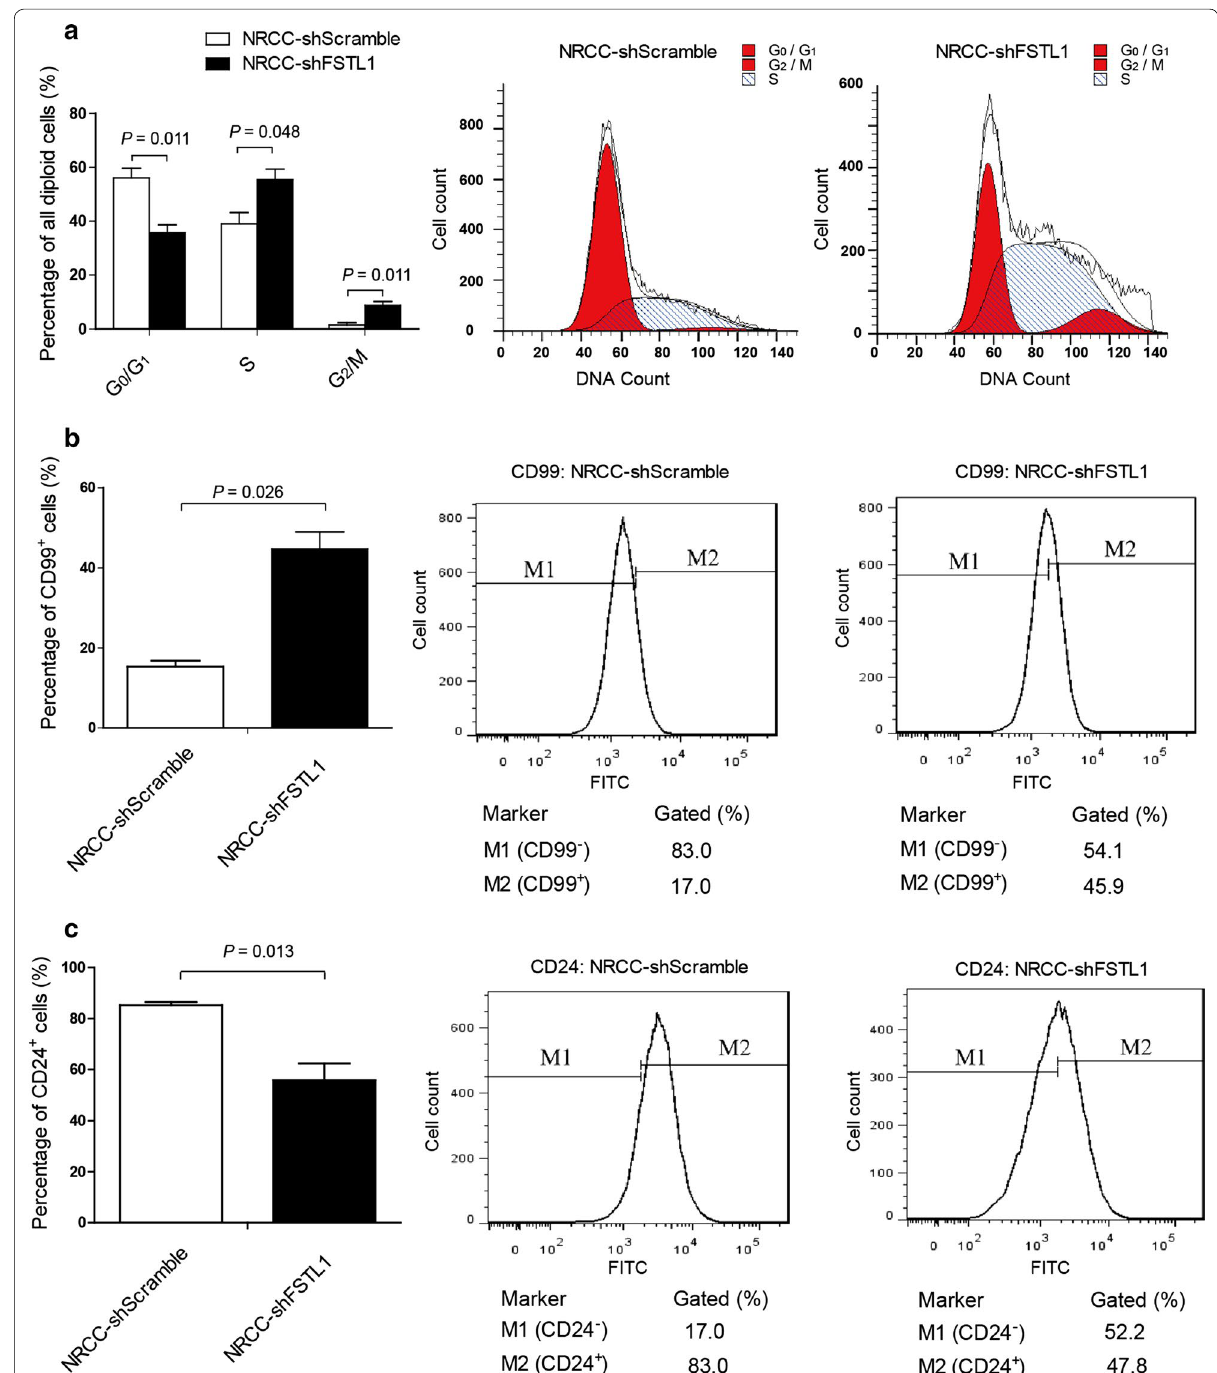
Fig. 3 Effect of FSTL1 knockdown on cell cycle and adhesion molecule expression in ccRCC cells. a Effect of FSTL1 knockdown on cell cycle progres- sion of NRCC cells. The percentage of cells in S and G 2 /M phases is higher in NRCC-shFSTL1 cells (55.4% 4.0% and 8.8% 1.4%) than in NRCC- ± ± shScramble cells (39.0% 4.2% and 1.5% 0.8%). The first and second peaks of the red curve represent the cell count of G 0 /G 1 and G 2 phases, ± ± respectively. The shaded plot reflects the cell count of S phase. b , c Effect of FSTL1 knockdown on the expression of CD99 and CD24 on NRCC cells. The percentage of CD99-positive cells is higher in NRCC-shFSTL1 cells (44.7% 4.3%) than in NRCC-shScramble cells (15.3% 1.5%), whereas the ± ± percentage of CD24-positive cells is lower in NRCC-shFSTL1 cells than in NRCC-shScramble cells